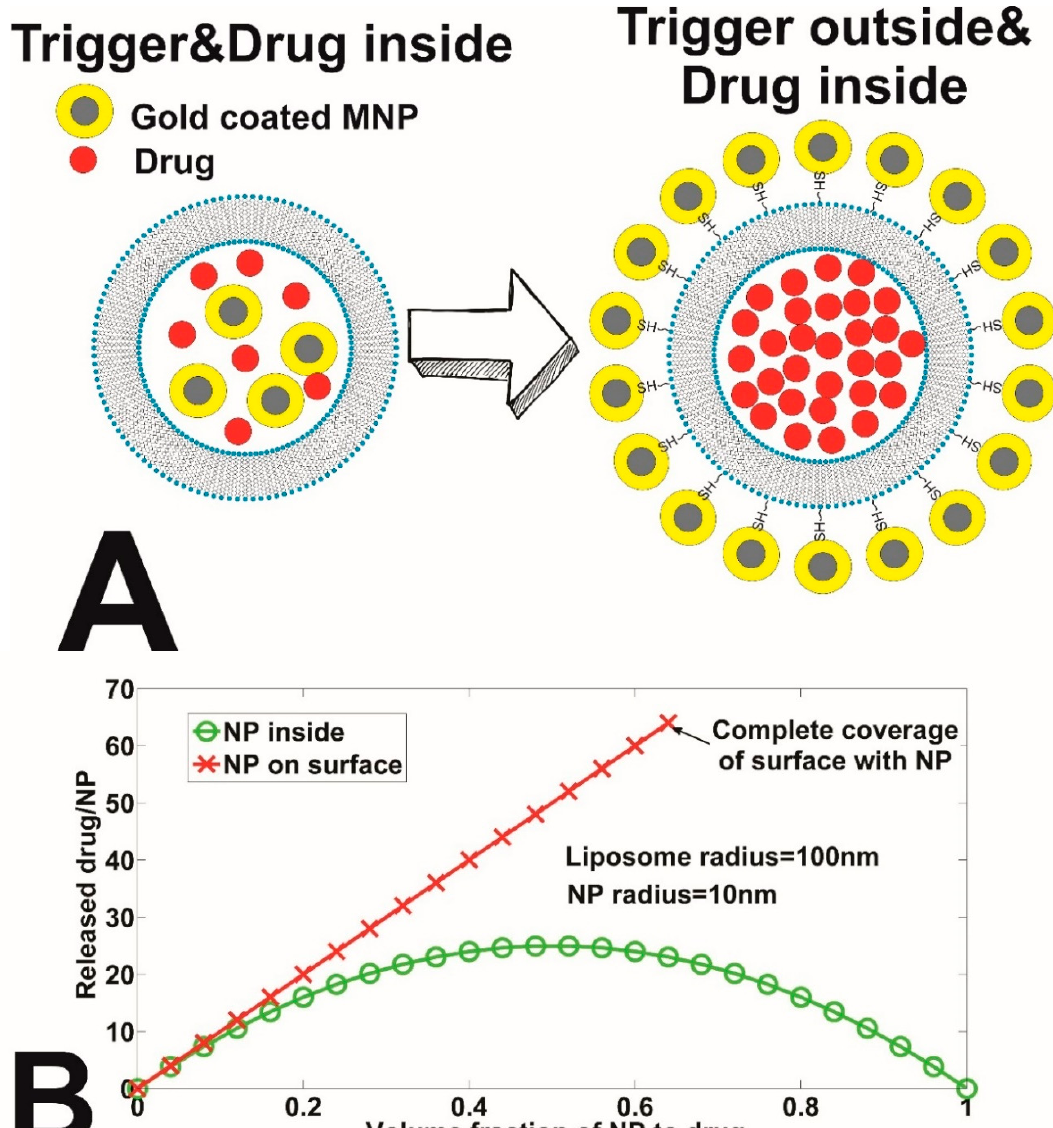
Figure 1. ( A ) Cholesterol–PEG–SH ligands to link nanoparticles with liposomes. ( B ) Calculated drug delivery efficiency as a fraction of Nanoparticle (NP) to drug for the two different compositions shown